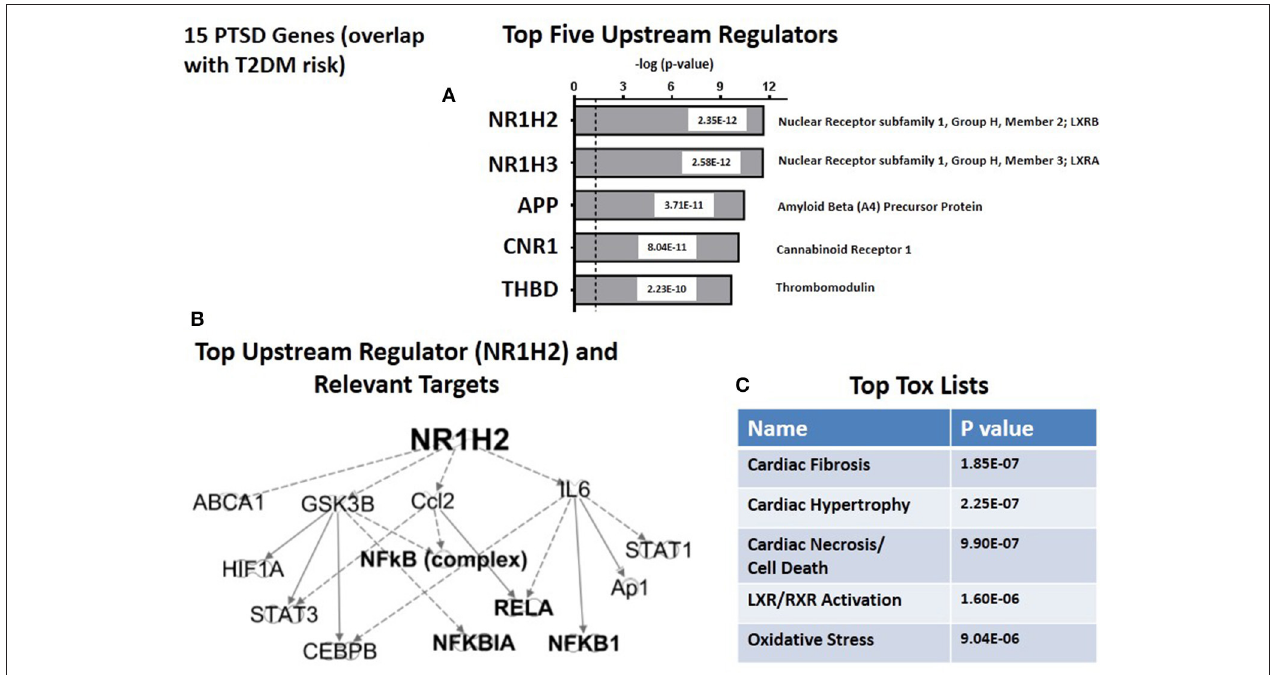
FIGURE 6 | Upstream regulation of risk genes for T2DM. (A) Predicted Top Upstream Regulators. The top two are LXRA and LXRB. (B) Predicted targets of the top upstream regulator, LXRB. (C) Predicted Top Tox (icology) Lists. The emphasisis on cardiac disease.